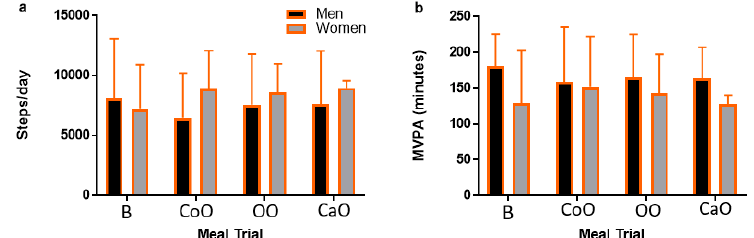
Figure 1. Pretrial physical activity. Physical activity in ( a ) steps / day and ( b ) MVPA for 48–72 h before